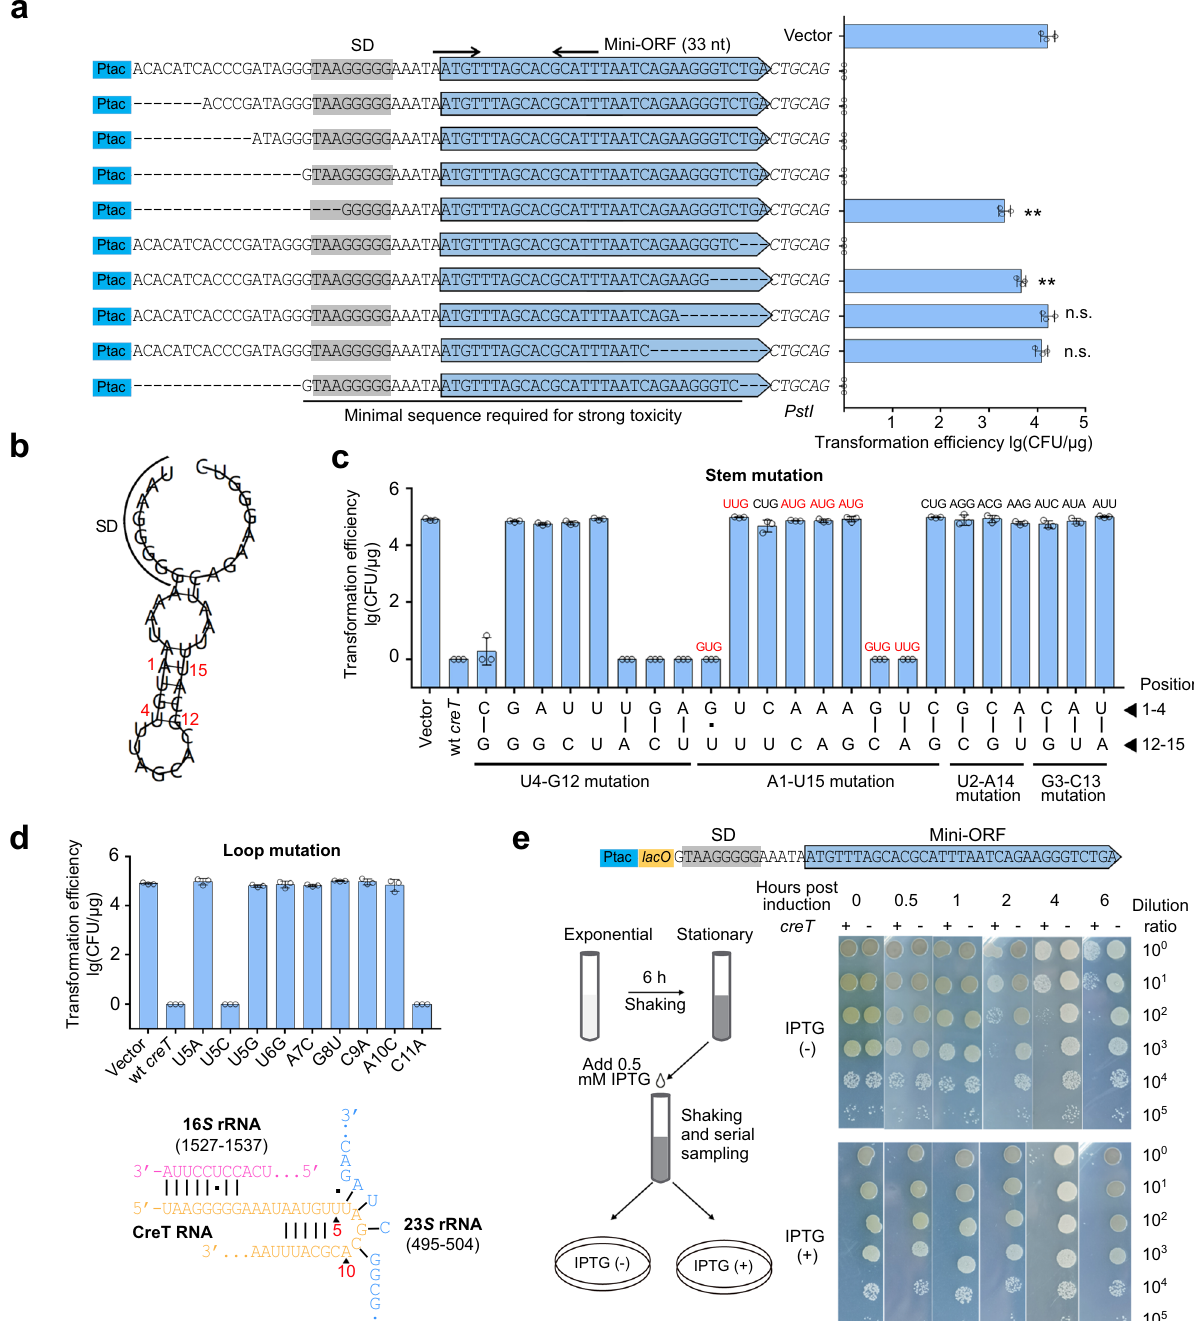
Fig. 4 | WCHA45 CreT is a bactericidal RNA that relies on translation initiation signals and a hairpin structure. a Truncation assay to determine the minimal sequence of creT that is required for toxicity. A synthetic tac promoter (P tac ) was used to drive creT transcription. Plasmids expressing CreT variants were used to transform AYE cells. Data are presented as mean value±s.d. ( n =3 biological replicates). Two-tailed Student ’ s t test [ n.s ., not signi fi cant ( P >0.05); ** P <0.01. P =0.001229433, 0.005484642, 0.960212531, 0.326149613 (topto bottom)]. b The predicted hairpin structure of CreT RNA. Nucleotide positions are indicated with respect to the start codon AUG. c Complementary mutation of the stem nucleo- tides. Plasmids expressing mutated CreT were used to transform AYE cells. For